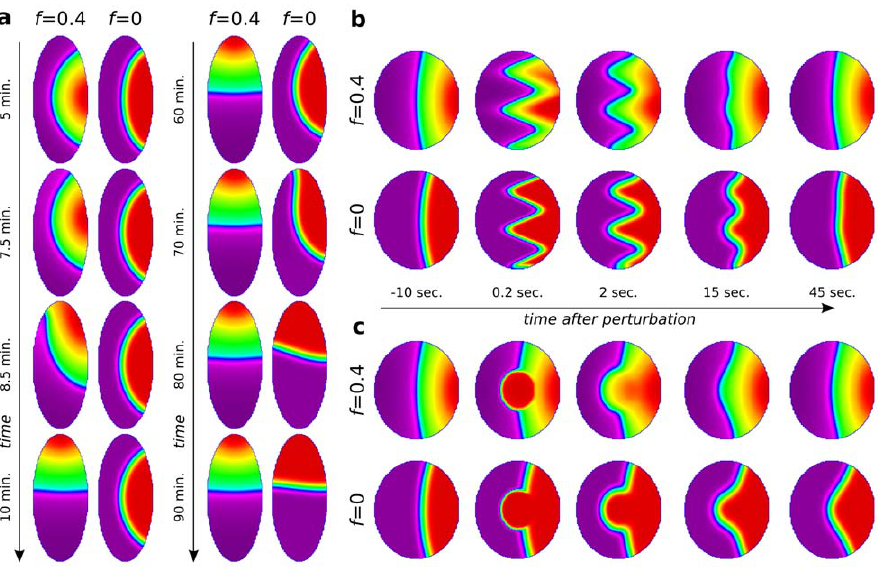
Figure 4. Effect of cell shape and intracellular ‘front-back’ interface curvatures. Shown are Cdc42 distribution profiles at indicated times using the colour scheme as in Fig. 2. ( a ) (and Video S2) Effect of cell shape on repolarization in the presence ( f ~ 0 : 4 , left) and absence ( f ~ 0 , right) of feedback from PIs to Rho GTPases. Cells with elliptical, static shape are initially polarized along their short axis using the standard, transient gradient protocol. Due to their shape alone (with no further stimulus or bias), there is a clear tendency for the cells to repolarize. The dynamics of shape- induced repolarization occurs much more rapidly when PI feedback is included. ( b ) Static circular cell in which the intracellular profiles have been modified into a highly curved profile. Over time, the curvature of the front-back interface flattens (with regions of higher curvature changing faster). ( c ) Local injection of Cdc42 appears to locally distort the intracellular interface, which then straightens again. Shape-sensitivity and robustness to local perturbations can be understood through the tendency of the reaction-diffusion system to minimize the front-back interface. The no-flux boundary conditions further assure that the all level curves (interfaces) maintain right-angles to the cell membrane. For the dynamics of (b,c), see also Video S3.